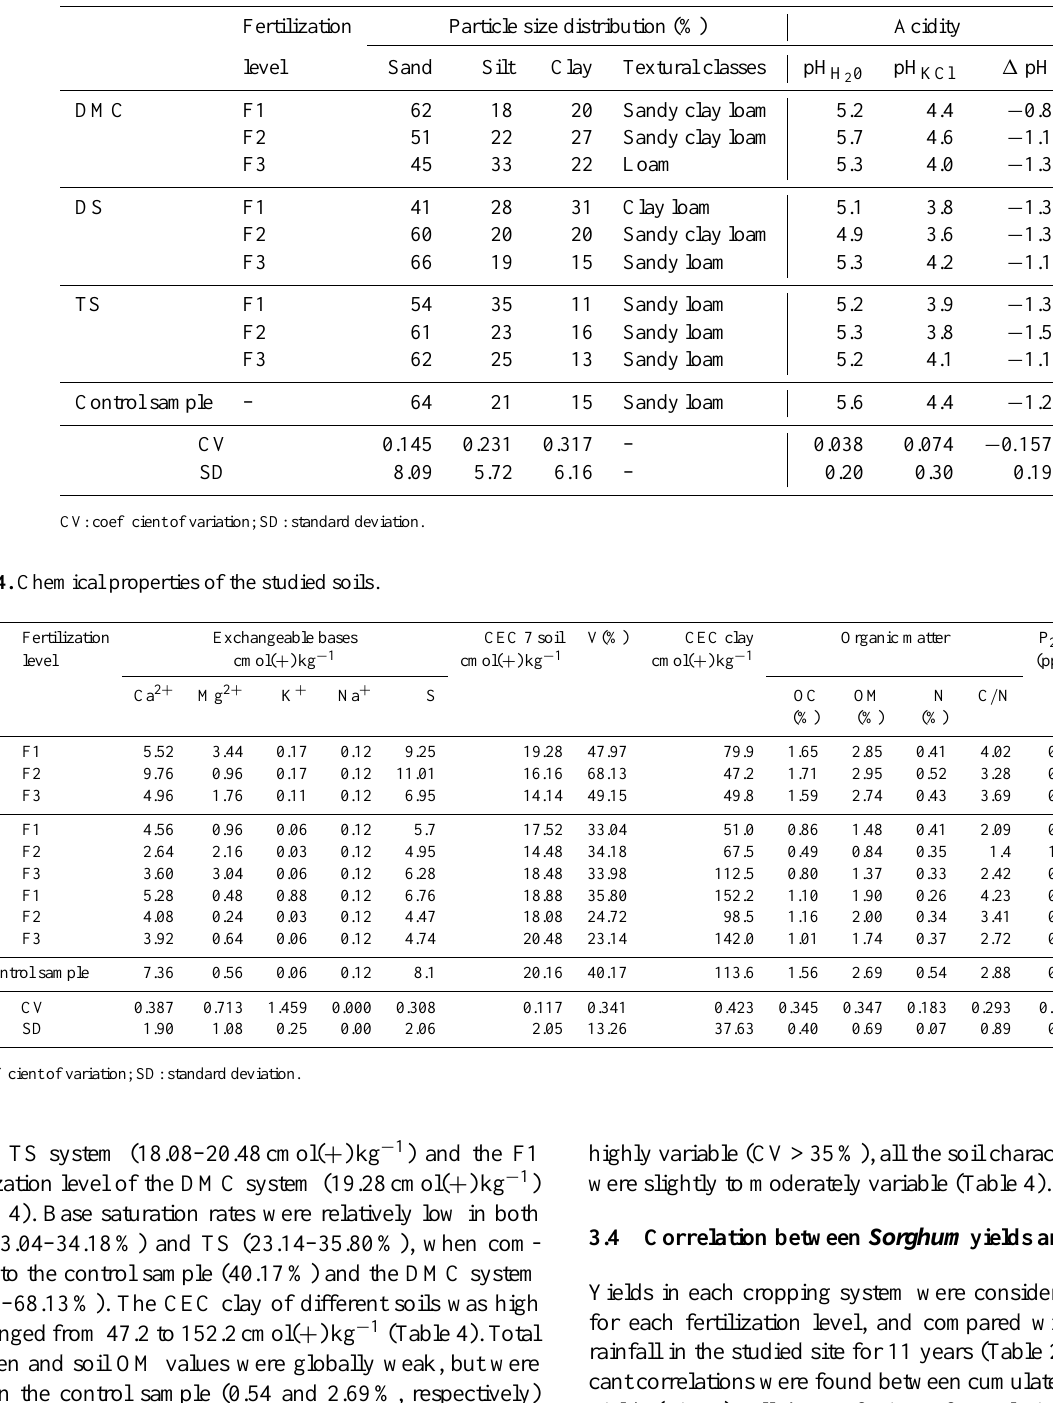
Table 3. Particle size distribution and acidity of the studied soils.